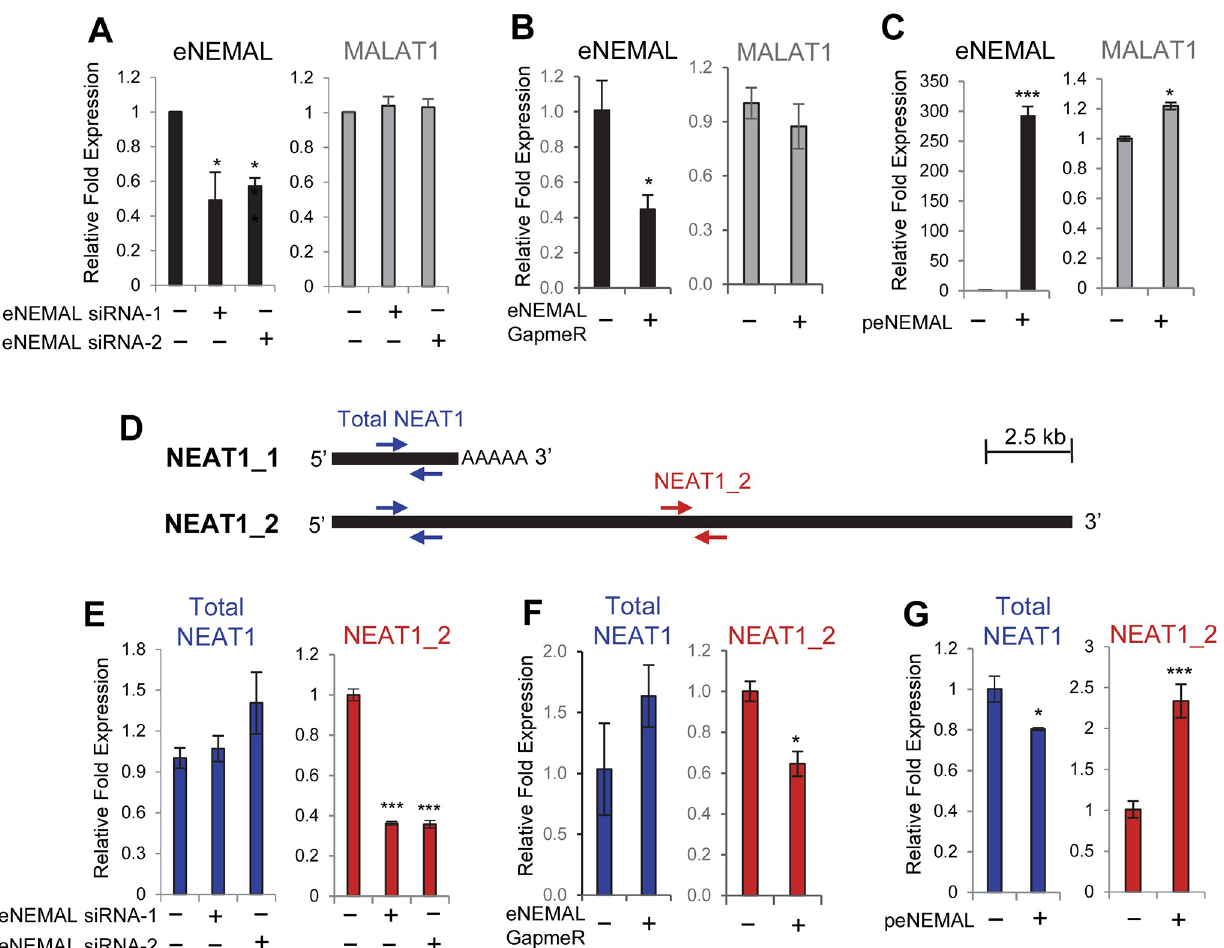
Fig 5. eNEMAL regulates NEAT1 isoform switching, resulting in upregulation of the NEAT1_2 long isoform in MCF7 breast cancer cells. ( A, B and C ) RT-qPCR measuring MALAT1 expression after knocking down or overexpressing eNEMAL. MCF7 cells were transfected with two different siRNAs targeting eNEMAL and maintained under hypoxia ( A ), transfected with GapmeR targeting eNEMAL and maintained under hypoxia ( B) , or transfected with eNEMAL-overexpressing plasmid (pCDH-eNEMAL) and maintained under normoxia ( C ). RNA was isolated 48 hours after siRNA/GapmeR/ plasmid transfection and used for RT-qPCR. ( D ) qPCR primer scheme to detect total NEAT1 (both the short isoform NEAT1_1 and the long isoform NEAT1_2; blue arrows) and NEAT1_2 only (red arrows). ( E, F and G ) RT-qPCR measuring total NEAT1 and NEAT1_2. MCF7 cells were transfected with eNEMAL siRNA and maintained under hypoxia ( E ), transfected with GapmeR targeting eNEMAL and maintained under hypoxia ( F ), or transfected with eNEMAL-overexpressing plasmid (pCDH-eNEMAL) and maintained under normoxia ( G ) prior to RNA isolation as described above. Data shown as mean ± SD, n = 4, � P < 0.01, ��� P <